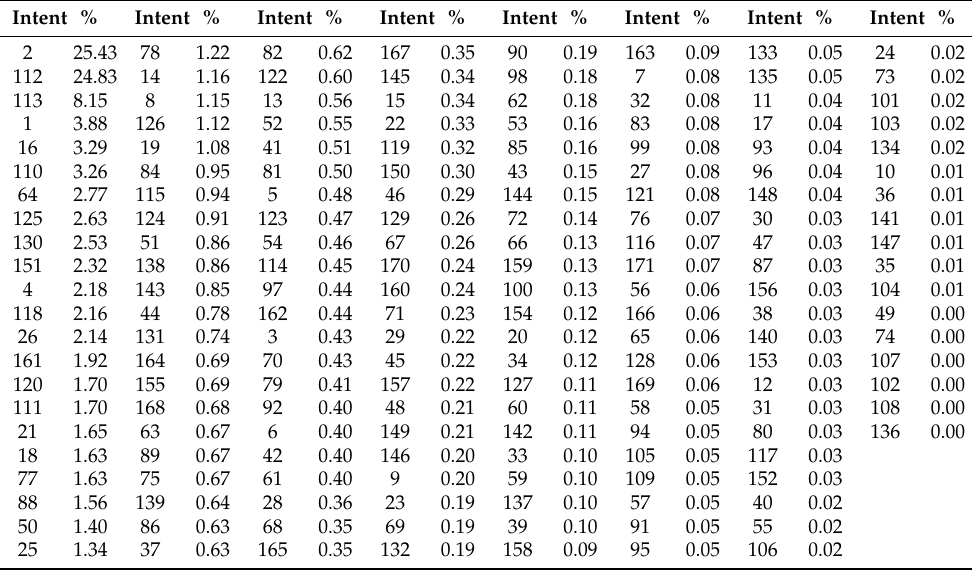
Table 6. Percentage of relevant Tweets falling in each class of intent, described in Section